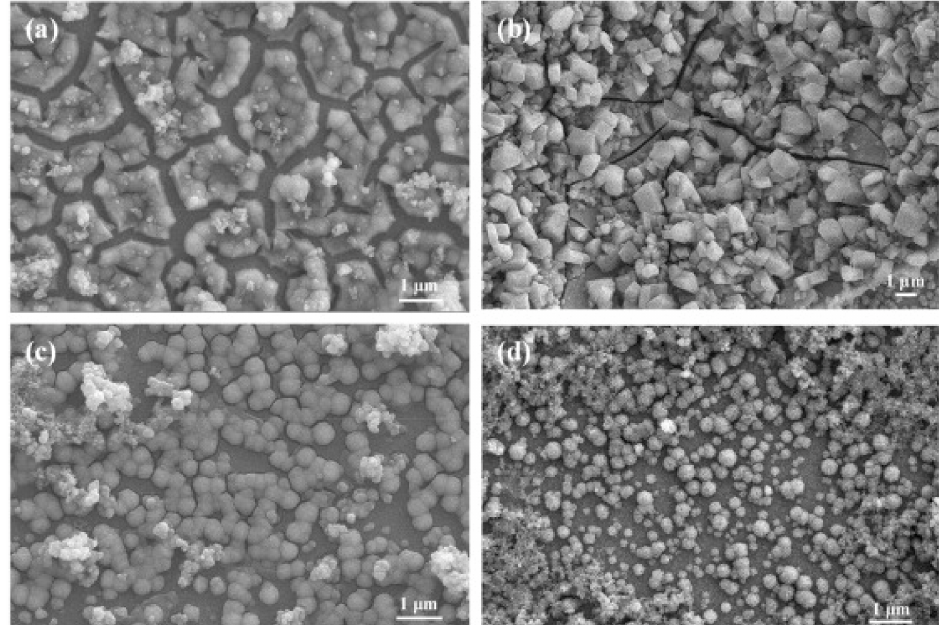
Figure 15. Images of fabricated Al:NiO thin films at different current densities. ( a ) (4 mAcm − 2 ), ( b ) (5 mAcm − 2 ), ( c ) (6 mAcm − 2 ), and ( d ) (7 mAcm − 2 ). Reprinted with permission from